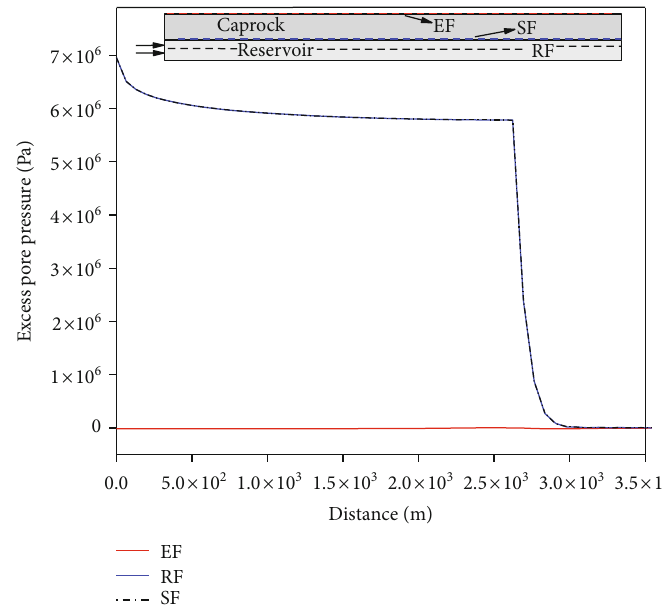
Figure 13: The excess pressure curve of the horizontal survey line.